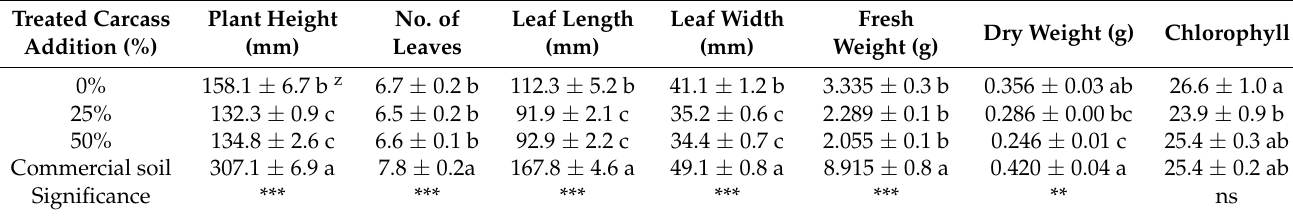
Table 3. Growth properties of lettuce cultivated under three different conditions, i.e., nutrient-poor soil and commercial soil amended with 0%, 25%, and 50% of treated carcass product, respectively.